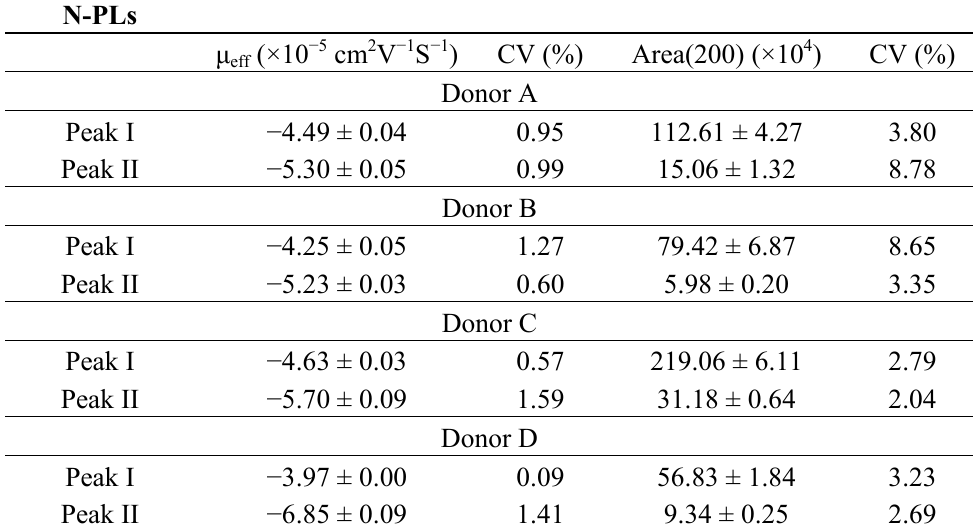
Table 5. The average effective mobility and peak area of native VLDL phospholipids analyzed by MEKC at absorbance 200 nm (data are means ± SD of four replicates).